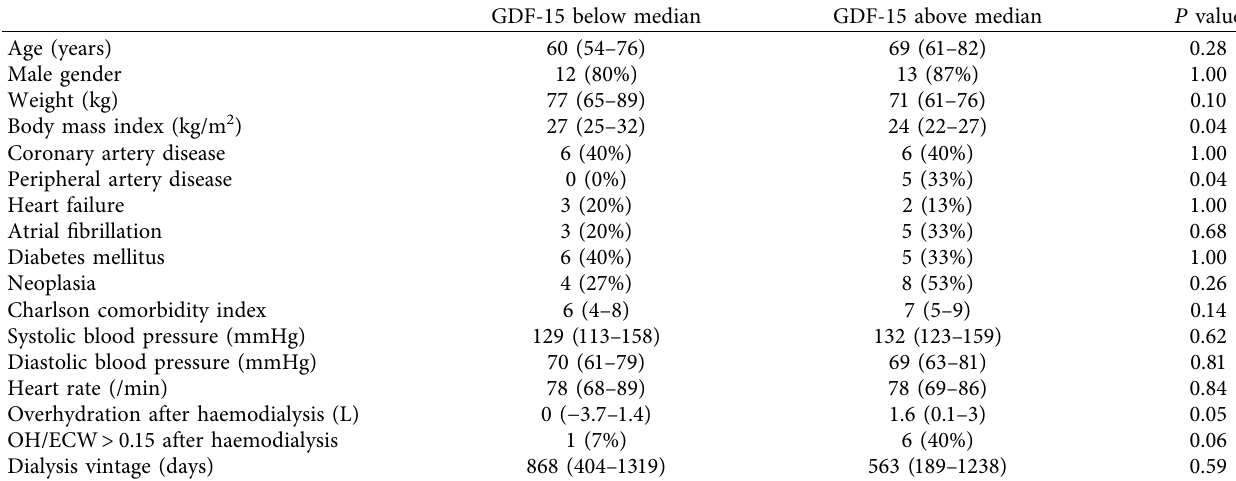
Figure 1: Prognostic properties of GDF-15 for 1-year mortality in haemodialysis patients. (a) Survival of haemodialysis patients according to circulating levels of GDF-15 after HD session. (b) Receiver operating characteristics (ROC) curve of GDF-15 for predicting 1-year mortality. AUROC: area under the receiver operating characteristic curve . Table 1: Baseline characteristics of the study population according to circulating GDF-15 after an HD